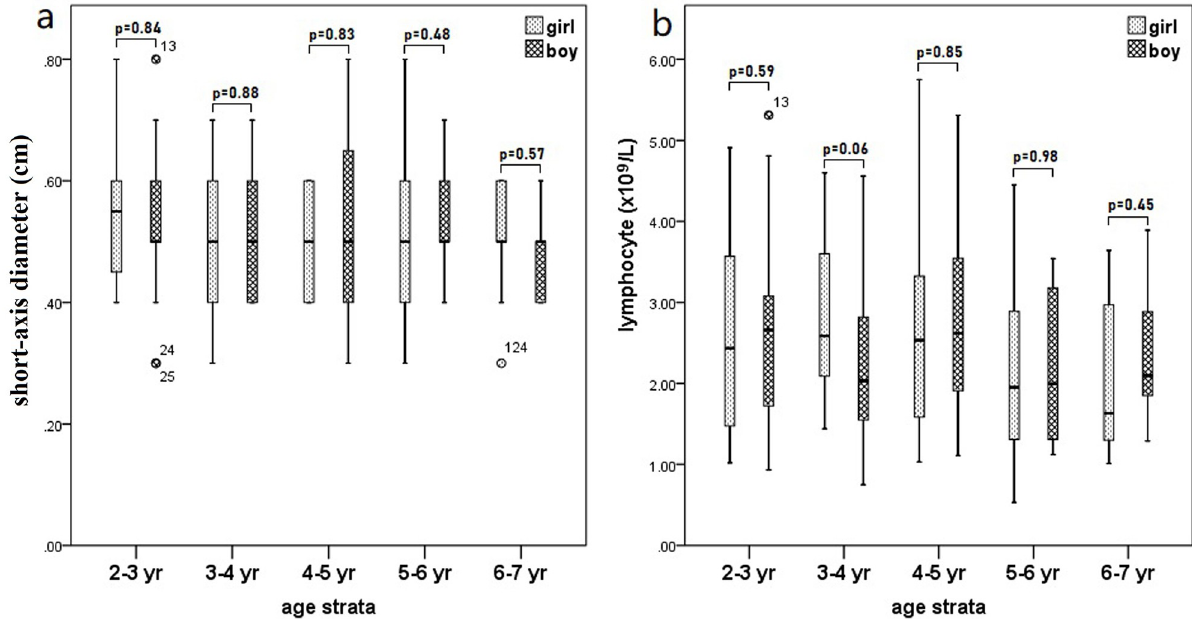
Fig 1. The short-axis diameters of the largest mesenteric lymph nodes (a) and lymphocyte counts (b) in each age group of children included in this study.